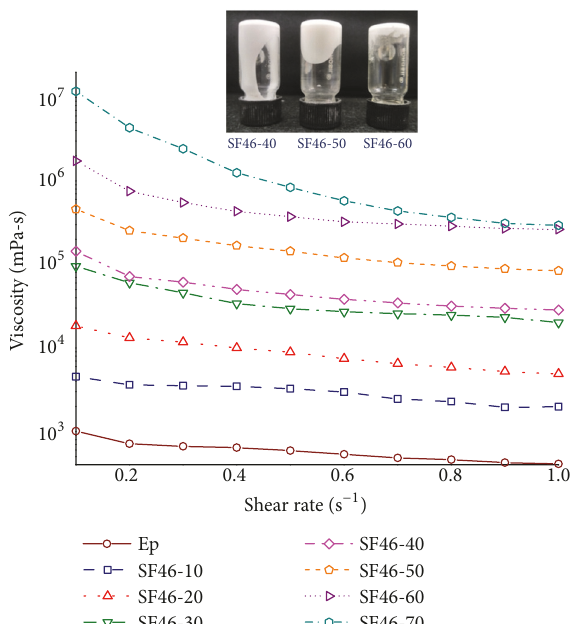
Figure 1: Dependence of increasing shear rate and microballoon loading ( 𝜙 ) on viscosity. Inset shows flowability of formulations at 40-60% (v/v) loadings of glass